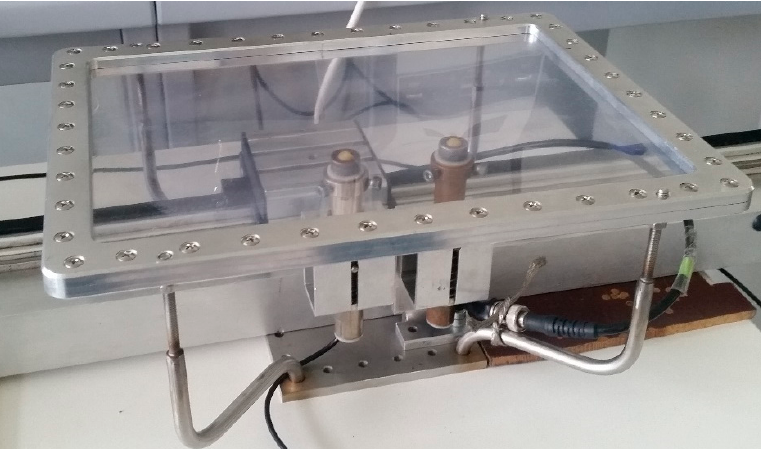
Figure 5. View of PVC film mounting bracket and ultrasonic transducers below the film.